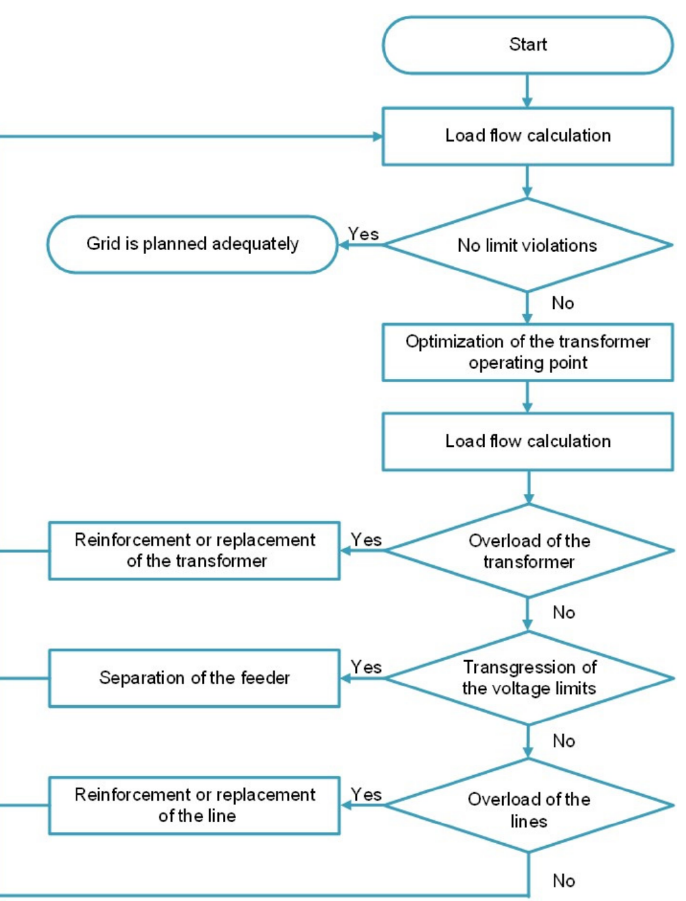
Figure 3. Proceeding for the selection of the required expansion measures within the classical planning method for medium-voltage